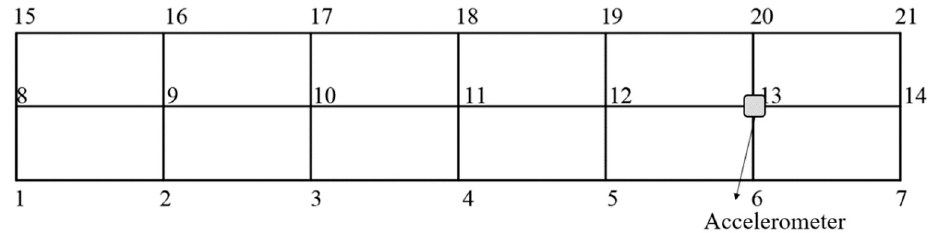
Figure 8. Exciting points division and accelerometer layout of the CFRP